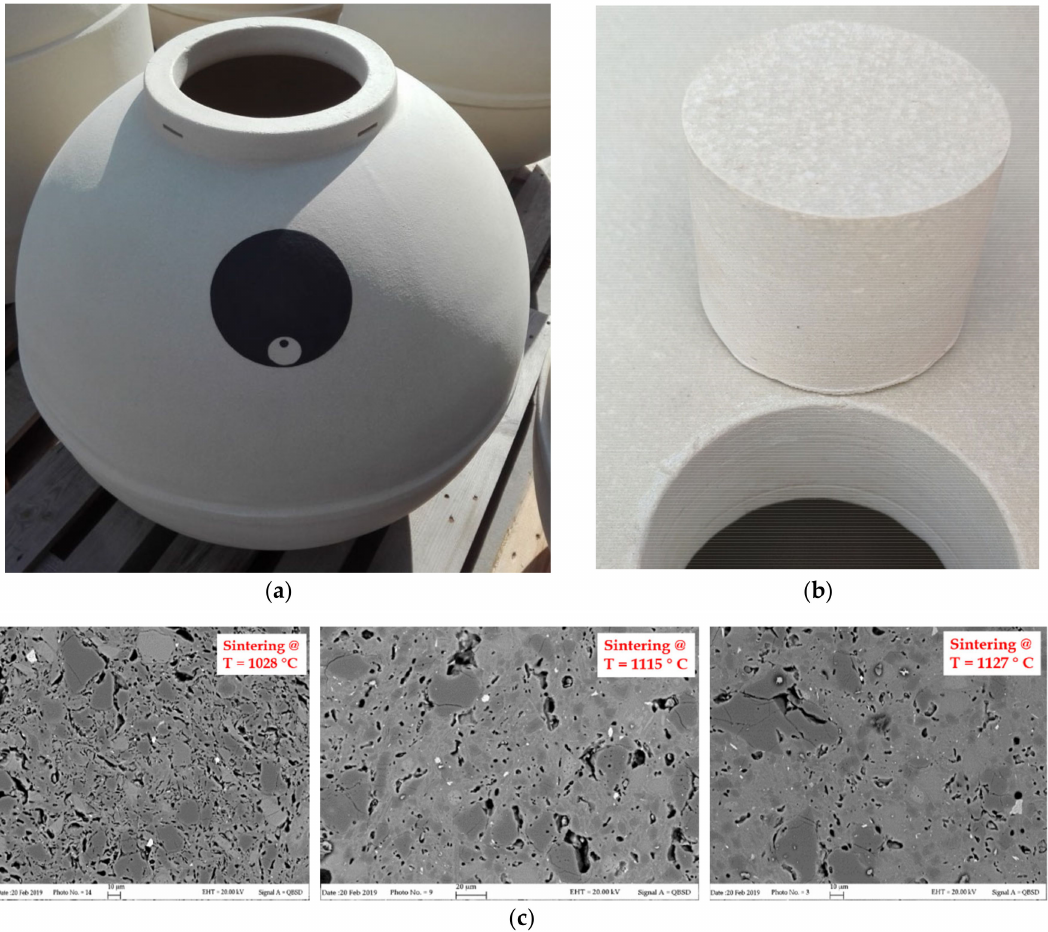
Figure 5. ( a ) 250-L claystone vessel and ( b ) extracted piece for its analysis where the ceramic structure of the material can be observed; ( c ) SEM analyses of different pieces at three sintering temperatures—1028 ◦ C, 1115 ◦ C, and 1127 ◦ C, respectively (images provided by Clayver , Savona,